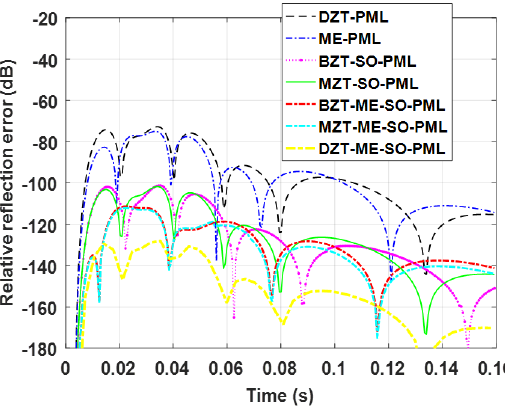
Figure 2. Relative reflection error ver-